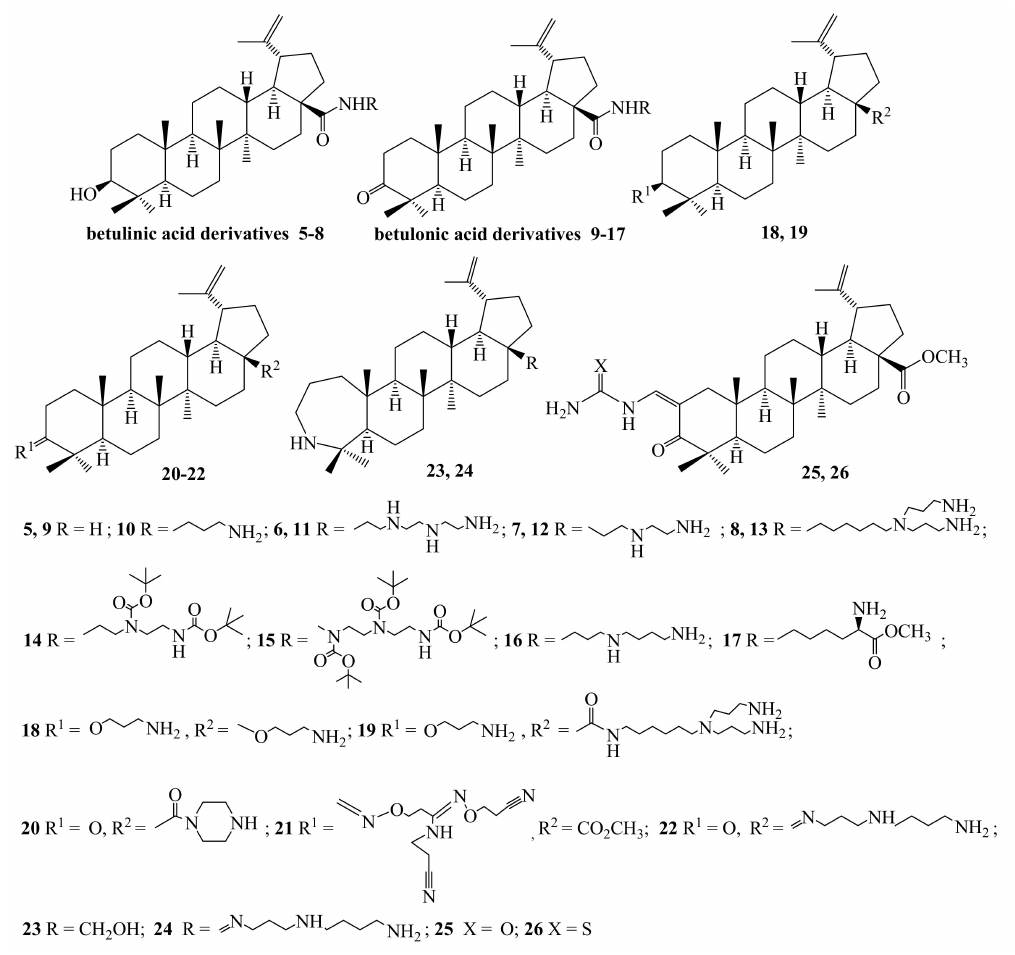
Figure 1. Compound 5 [26] ; compounds 6 , 7 , 11 , 12 , 14 , 15 , 16 , 19 [23] ; compounds 8 , 9 , 13 [18] ; 10 [27] ; 17 [28] ; 18, 25 , 26 [6] ; 20 , 21 [20] ; 22, 24 [24] ; 23 [9]